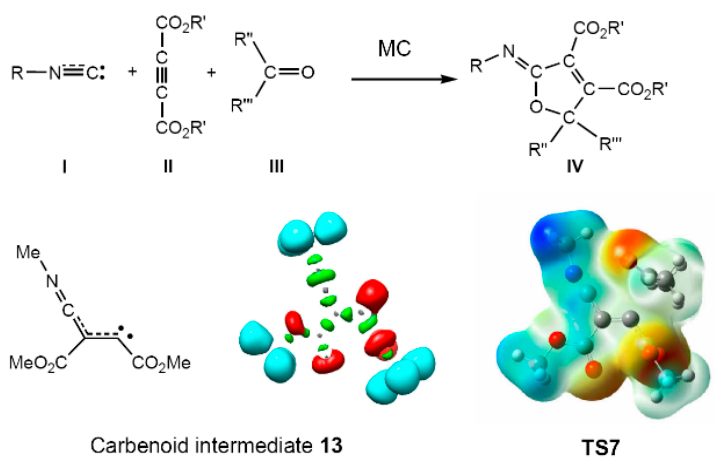
Figure 7. ELF valence basins of the highly nucleophilic carbenoid intermediate 13 and the MEP of TS7 , associated with the nucleophilic attack of carbenoid intermediate 13 on ketone. ELF valence basins were represented at an isosurface value of 0.8. Calculations were performed at the MPWB1K/6-311G(d,p) level.